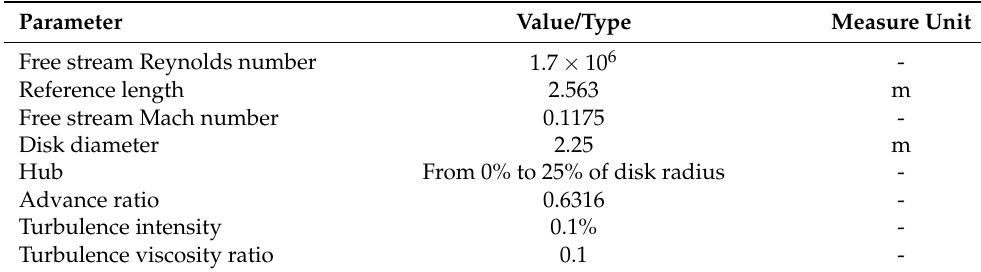
Table 3. Reference data for DEP test